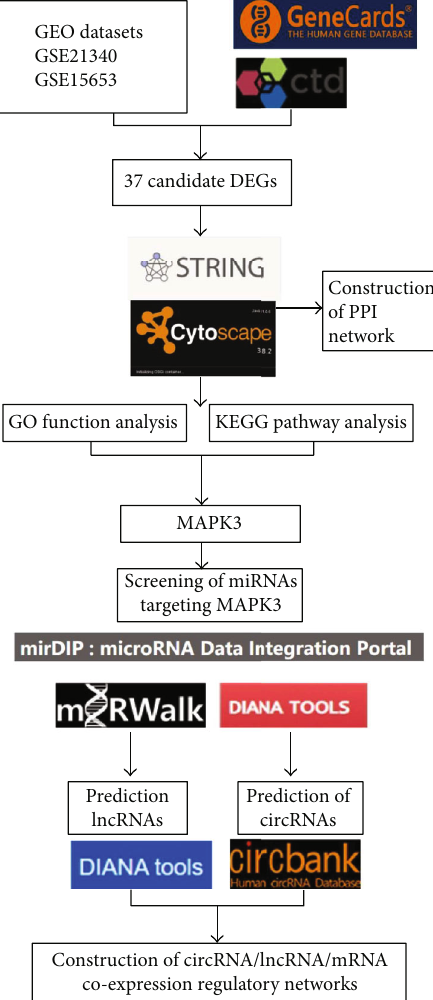
Figure 1: Flow chart of bioinformatics